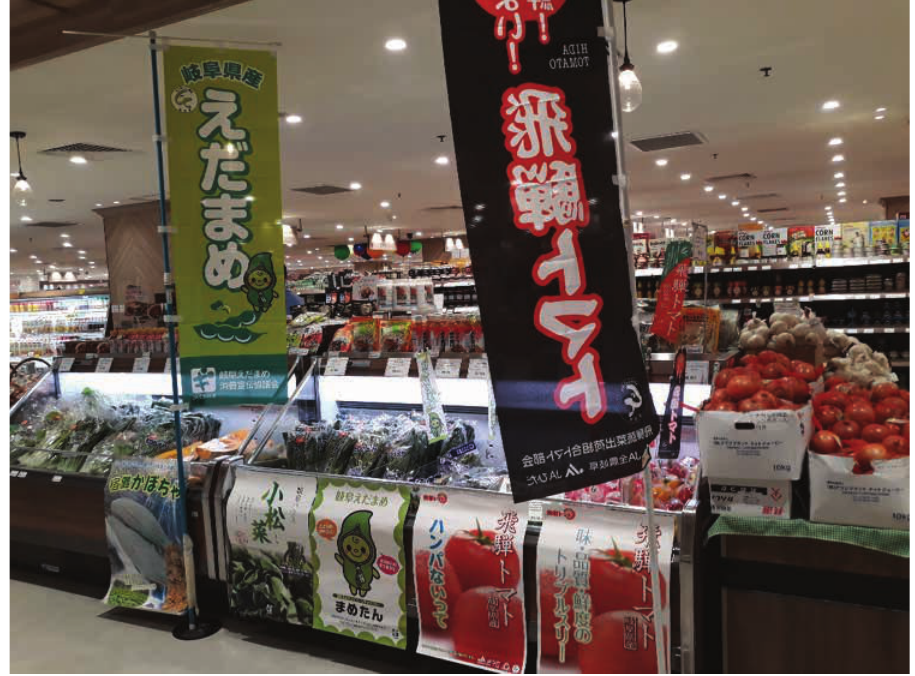
Figure 2: Original authenticity: produce from